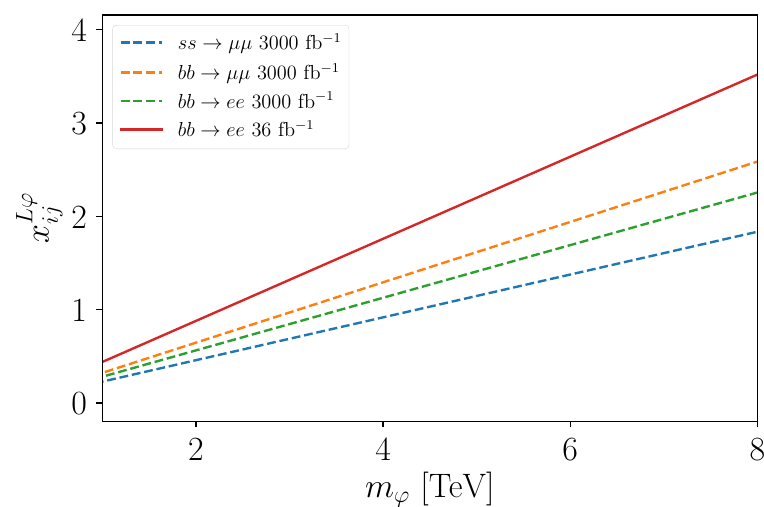
Figure 9. The (cid:12)gure shows the current (solid) and projected (dashed) upper limits on the couplings of the ’ LQ to down-type quarks and charged leptons x L’ . The limits are from LHC searches in ij pp ! ‘‘ high- p T tails at 13 TeV from ATLAS [108], derived from ref. [107]. The Yukawa